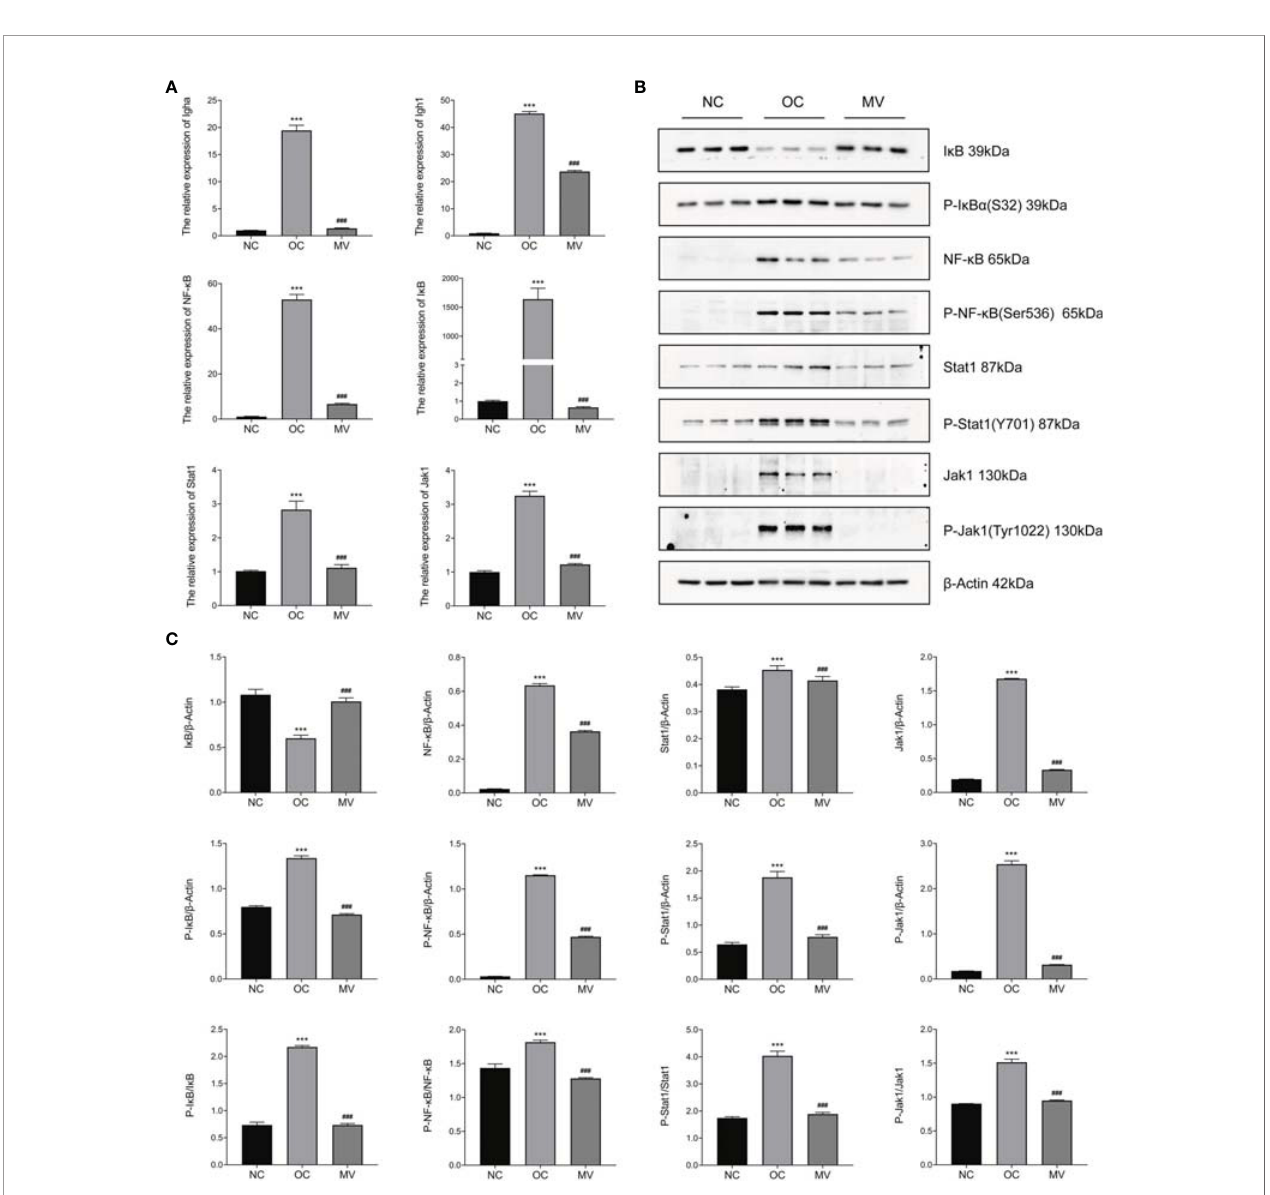
FIGURE 7 | Expression levels of Igha, Ighg1, NF- k B, I k B, Jak1, and Stat1 by qRT-PCR and Western blot (WB). (A) The relative mRNA expression levels of Igha, Ighg1, NF- k B, I k B, Jak1, and Stat1 were measured by qRT-PCR and normalized to that of b -actin. (B) Western blot. (C) The relative protein expression levels of Igha, Ighg1, NF- k B, I k B, Jak1, and Stat1 were measured by WB and normalized to that of b -actin. All values are mean ± SEM ( n = 3) by one-way ANOVA. *** P < 0.001, normal control group vs . ovalbumin control group (OC); ### P < 0.001, OC vs. the group treated with 50 mg/kg mogroside V